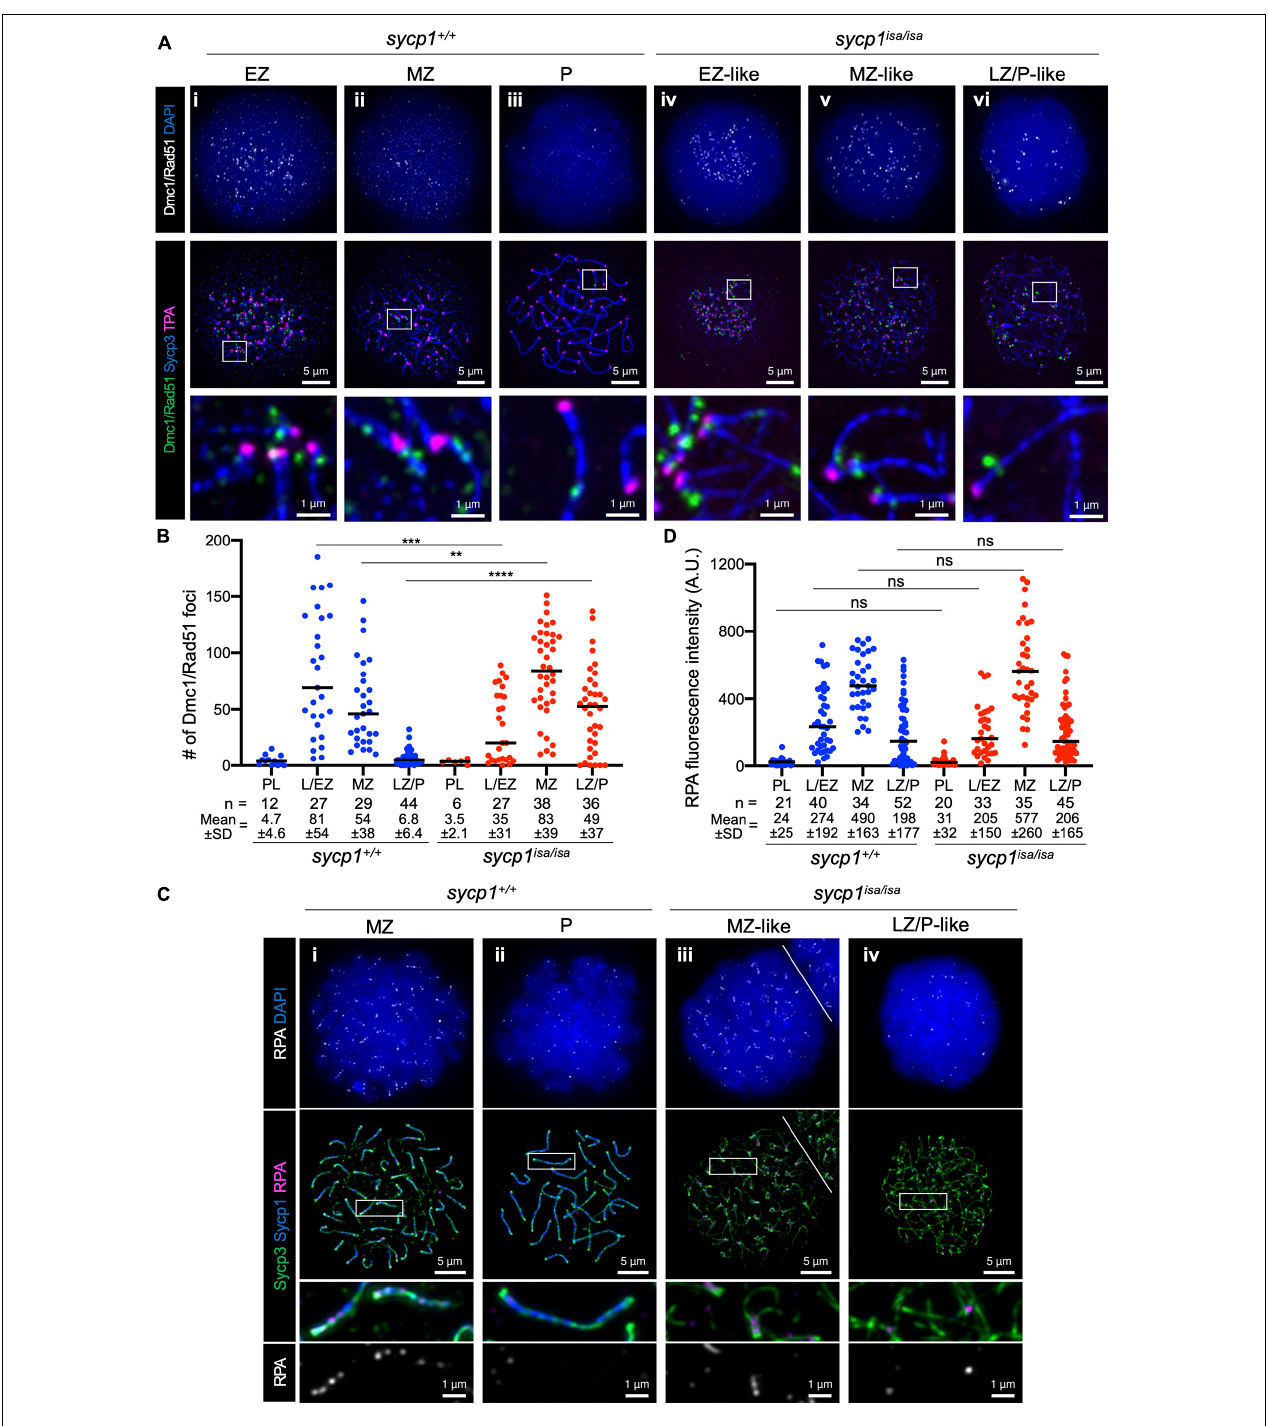
FIGURE 6 | DSB localization in sycp1 mutant spermatocytes. (A) costaining of Dmc1/Rad51, telomeres and Sycp3 in sycp1 + / + (i to iii) and sycp1 isa / isa (iv to vi) spermatocytes. (B) quantification of Dmc1/Rad51 focus numbers in sycp1 + / + and sycp1 isa / isa spermatocytes. Black bars indicate means. Statistical significance was examined by a two-tailed Mann-Whitney test (** P < 0.01, *** P < 0.001, **** P < 0.0001; exact P value). (C) costaining of RPA, Sycp1 and Sycp3 in sycp1 + / + (i and ii) and sycp1 isa / isa (iii and iv) spermatocytes. Regions marked as a white rectangle in the middle panels are shown at a higher magnification at the bottom. The white line on (iii) indicates a border with another nucleus on the top right. (D) quantification of RPA signal intensity in sycp1 + / + and sycp1 isa / isa spermatocytes. Black bars indicate means. Statistical significance was examined by two-tailed Mann-Whitney test (ns, not significant; exact P value). Since RPA is observed as short stretches rather than discrete foci, signal intensity rather than the number of foci in a nucleus was quantified here. Quantification of RPA focus numbers is shown in Supplementary Figure 5 .